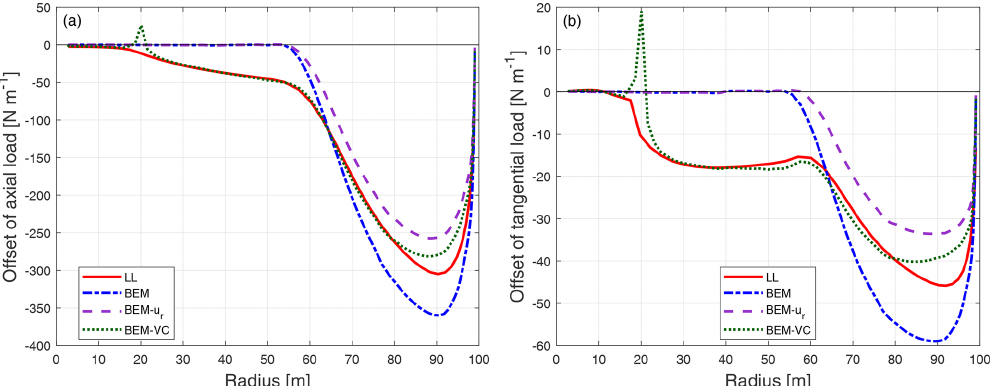
Figure 20. Comparison of the difference of the axial load (a) and tangential load (b) of the dihedral blade W-1-U15 compared to the baseline blade calculated from different models. The wind speed is 15ms − 1 , the tip-speed-ratio is 6.0 and the additional twist angle θ p is 11.77 ◦ .